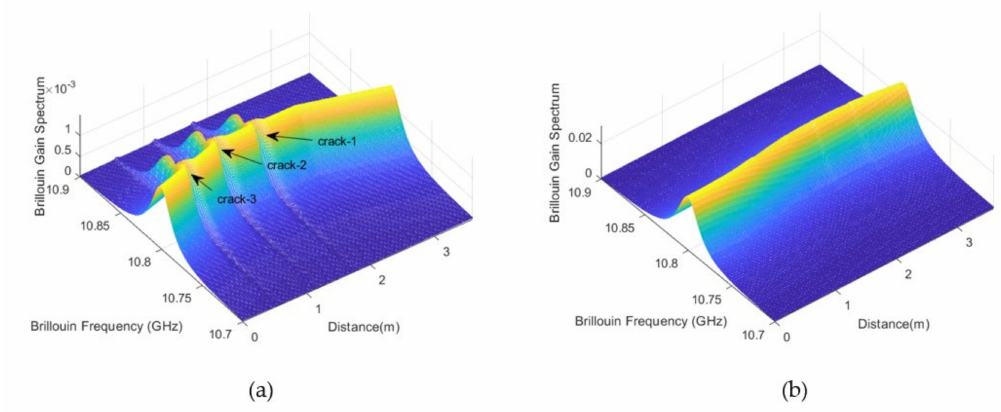
Figure 9. Comparison of Brillouin gain spectrum obtained by DPP-BOTDA and BOTDA systems ( a ) DPP-BOTDA ( b )